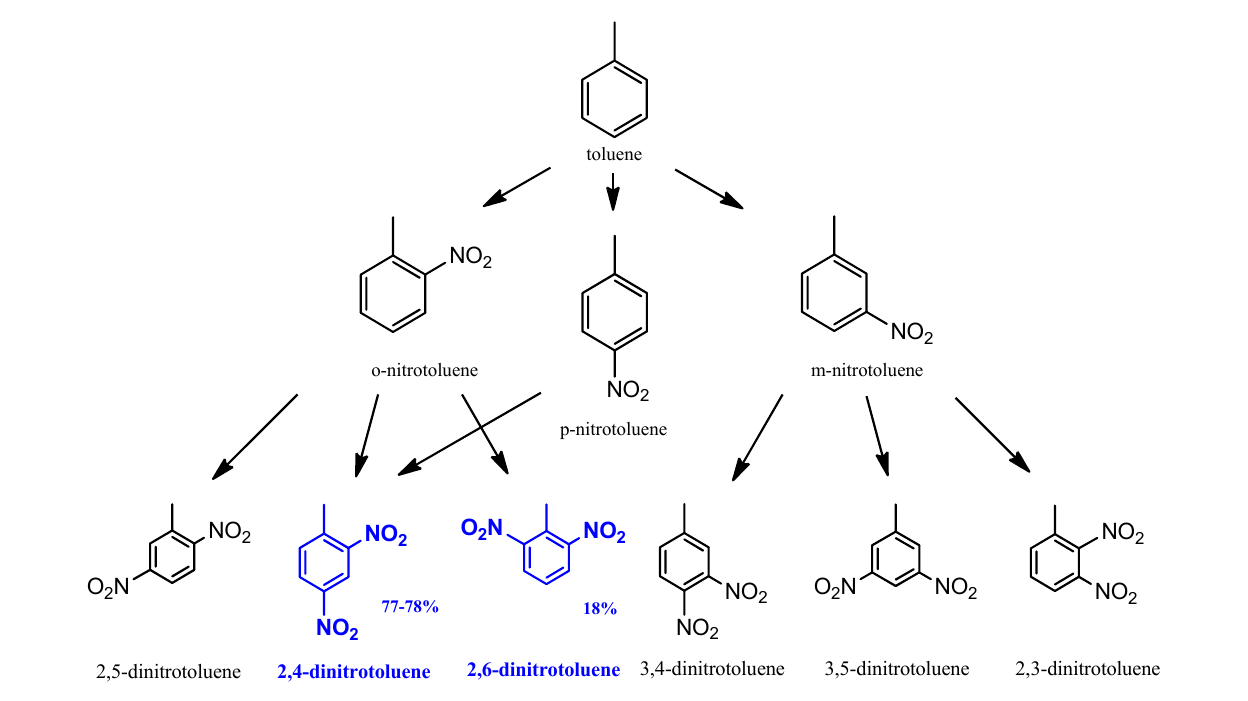
Figure 2. Raw material of hydrogenation process [26] .